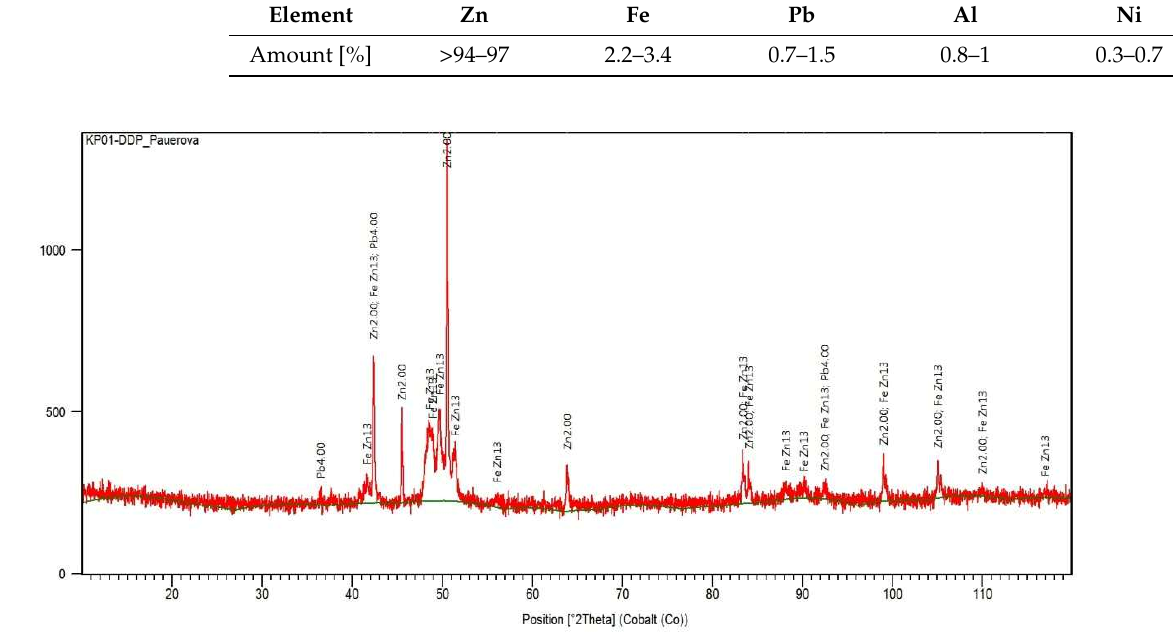
Table 1. Chemical composition of the bottom zinc dross sample by AAS analysis.